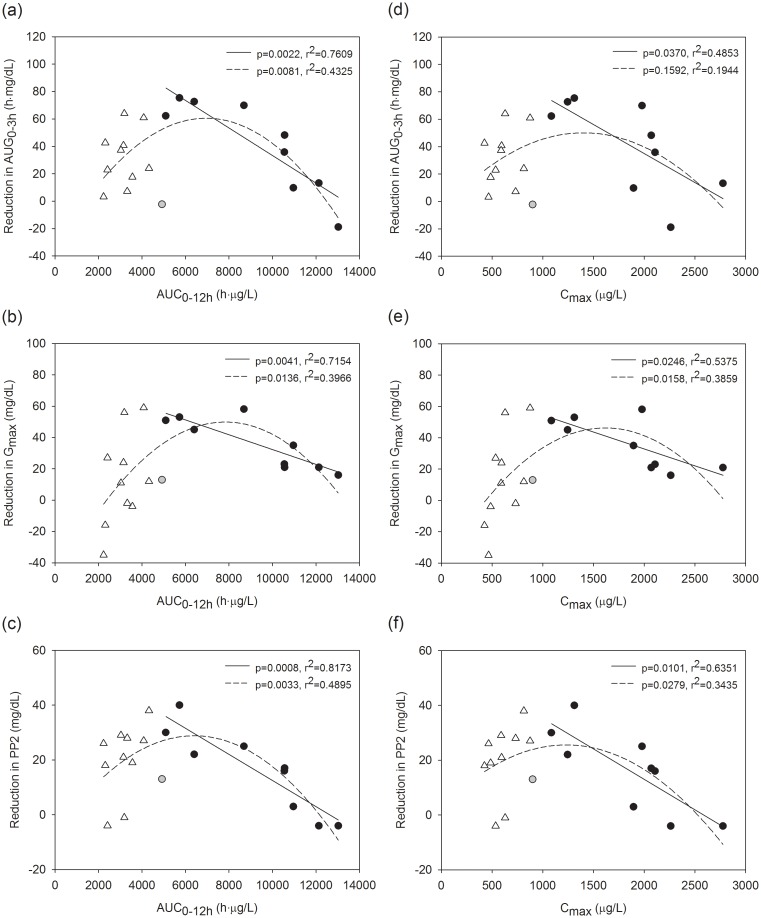
Relationships between pharmacokinetic-pharmacodynamic parameters after metformin administration at 250 mg (triangle) and 1000 mg (circle). Reduction in (a) AUG0-3h, (b) Gmax, and (c) PP2 versus AUC0-12h; reduction in (d) AUG0-3h, (e) Gmax, and (f) PP2 versus Cmax.(The solid lines and dashed lines represent the linear and quadratic models, respectively. The black circle represents data included in the linear regression at high exposure. P-values are from the F-tests, and r2 represents the coefficient of determination.).